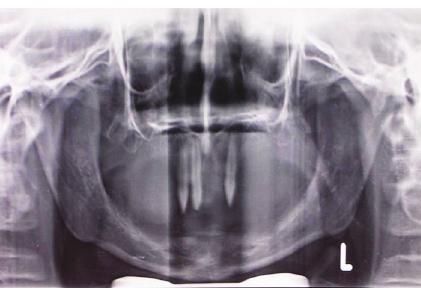
Figure 3: Orthopantograph-showing presence of 11, 12, and 23.